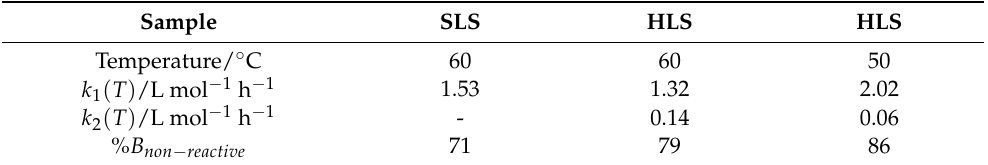
Table 6. Reaction rate constants and percentage of reactive phenolic groups for the studied methylo- lations at 60 or 50 ◦